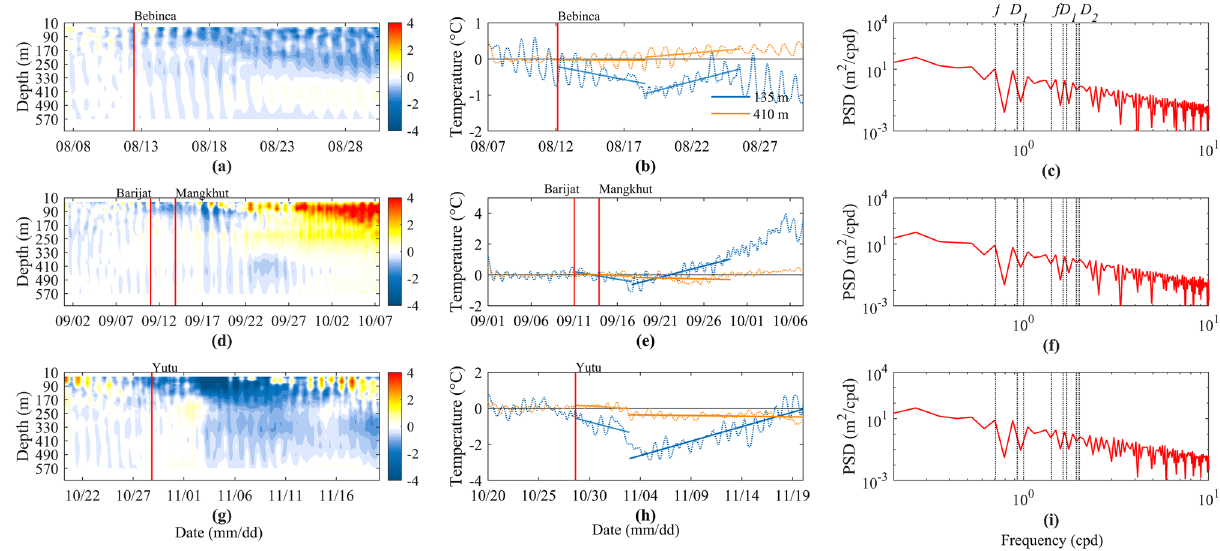
Figure 8. Spatio-temporal distribution of temperature anomaly (temperature minus the average temperature of the 4 days before the passage of typhoons, ( a,d,g )), time series of temperature at a depth of 135 m and 410 m ( b,e,h ), and spectra of average vertical displacement of the isotherms from 8 °C to 18 °C ( c,f,i ) during the passage of typhoons Bebinca ( a–c ), Barijat and Mangkhut ( d–f ), and Yutu ( g–i ), respectively. The red vertical lines are same as Fig. 1. The black lines are thermocline intensity. The blue lines are temperature at the depth of 135 m. The orange lines are temperature fitting curves. The eight black vertical lines are same as Fig.